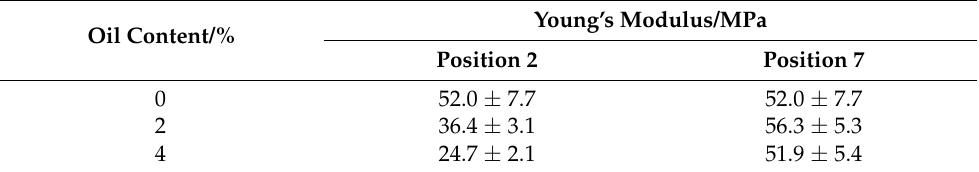
Table 5. Influence of oil content on the mean Young’s modulus for samples with oil addition at position 2 and at position 7. The barrel temperature was 120 °C and screw speed was 400 rpm.